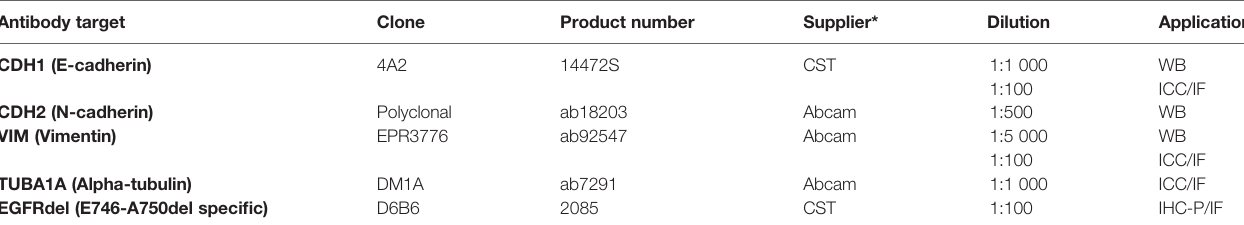
TABLE 2 | Antibodies for western blot (WB), Immunocytochemistry with immuno fl uorescent detection (ICC/IF), and Immunohistochemistry of paraf fi n sections with immuno fl uorescent detection (IHC-P/IF). Antibody target Clone Product